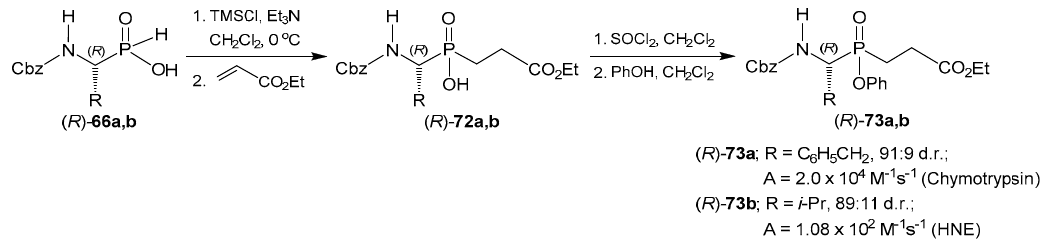
Scheme 31. Synthesis of phenyl phosphinate derivatives 73a , b and second-order rate constants [A = k/K i ] of inhibition of chymotrypsin and human neutrophile elastase (HNE).